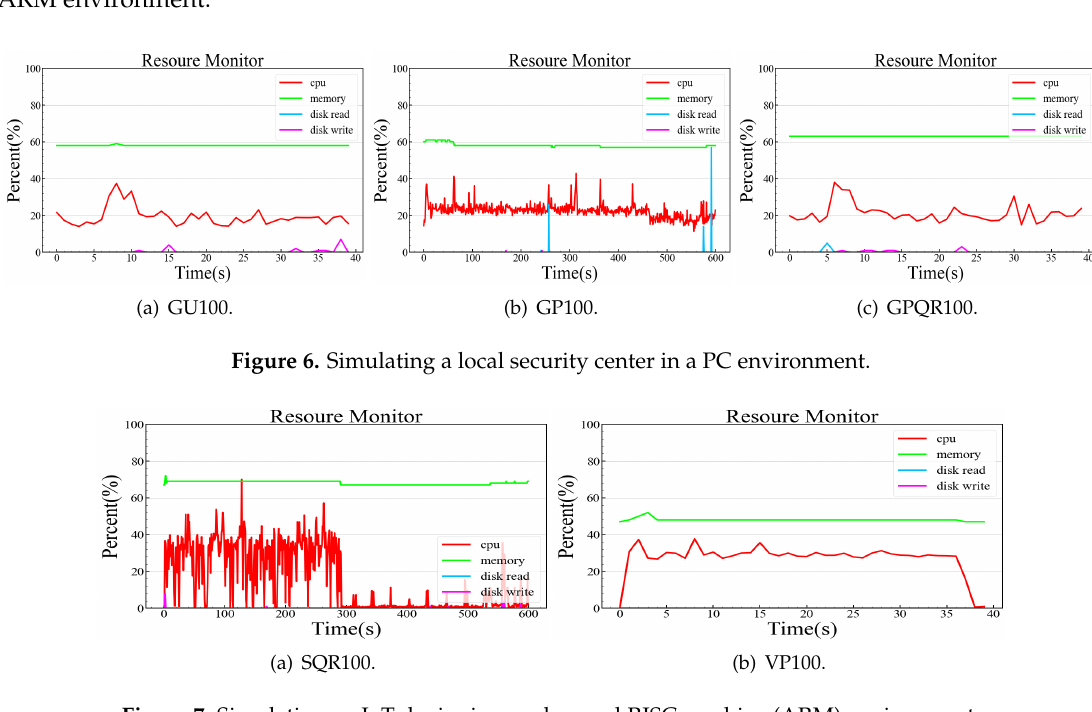
Figure 7. Simulating an IoT device in an advanced RISC machine (ARM)